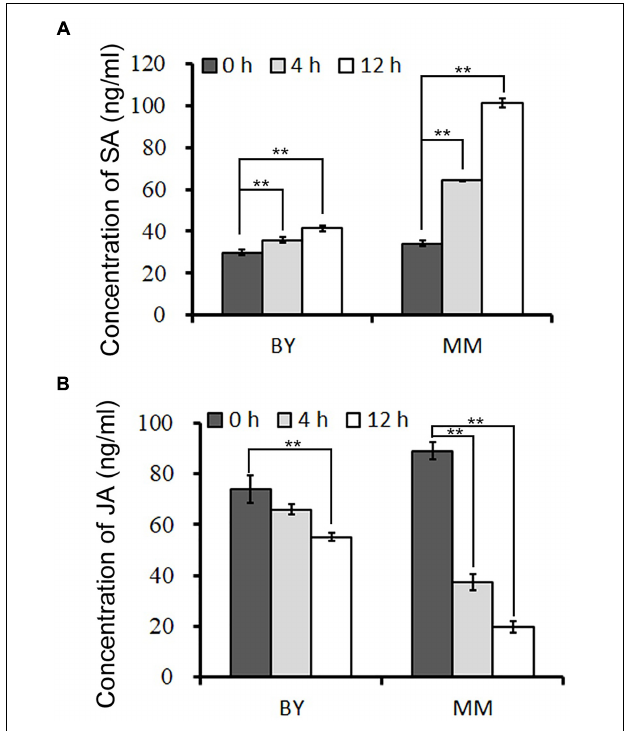
FIGURE 5 | The concentrations of SA and JA after downy mildew inoculation. The concentrations of SA (A) and JA (B) in inoculated leaves were measured at 0, 4, and 12 h after downy mildew inoculation. The 50 mg leaves from 5 to 10 20-day old seedlings were collected in each sample. Values represent means ± SD ( n = 3) from three biological replicates. Statistical significance between 0 and 4 or 12 h after inoculation in BY or MM was by a t -test: ∗∗ P <